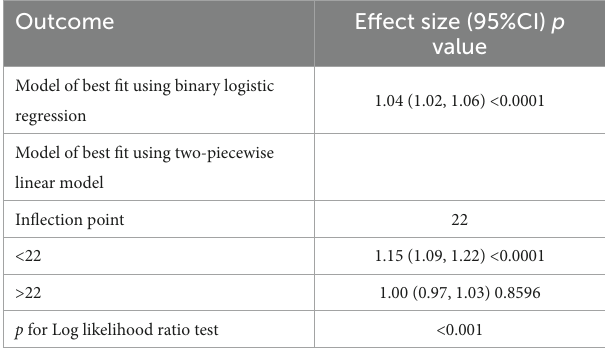
Table 2 were modified. OR: Odds ratio; CI: confidence interval; Ref: reference. TABLE 6 Nonlinearity of PT on ICU mortality.